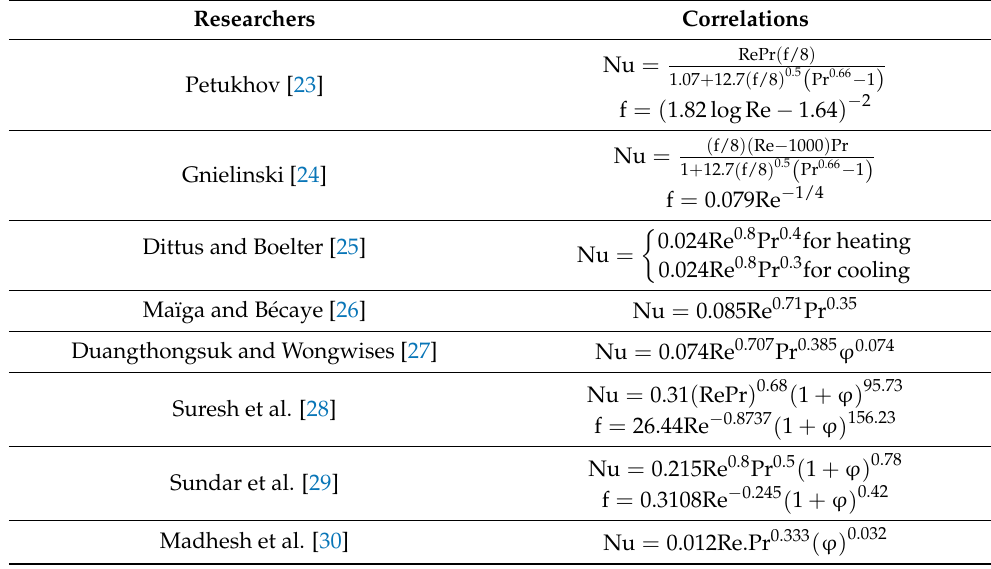
Table 5. Correlation relations for Nusselt number and flow friction for various flow